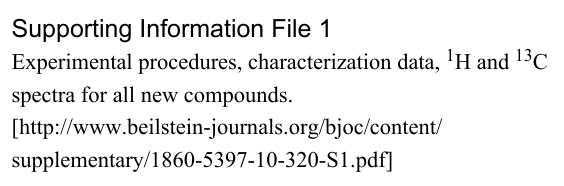
tions 4 and 12 of compound 6a was first established by analysis of the 1D and 2D NMR spectra. Thus, a 3 J coupling constant of 1.9 Hz corresponds with a cis -orientation and the NOESY experiment additionally supports the proximity of this pair of